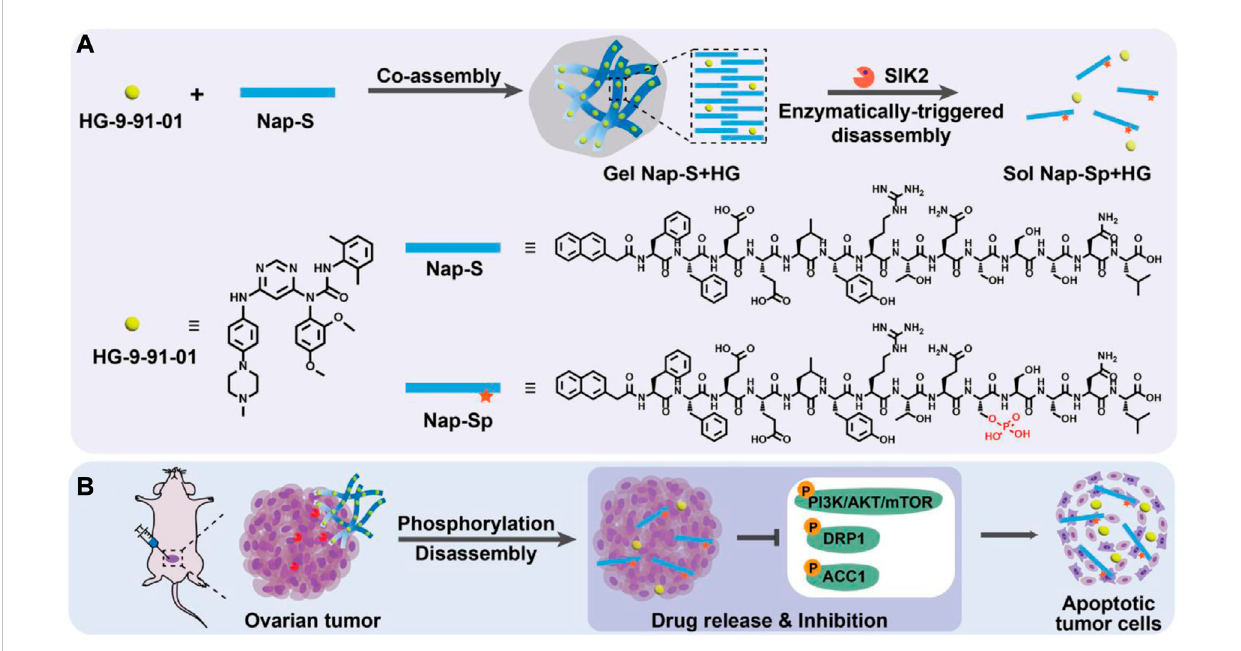
FIGURE 6 Chemicals and conceptual illustrations are included in this work. (A) Gel Nap-S + HG is formed and then disassembled to release HG via SIK2- mediated Nap-S phosphorylation to Nap-Sp, as shown schematically. (B) OC cells can be effectively induced to undergo apoptosis via inhibition